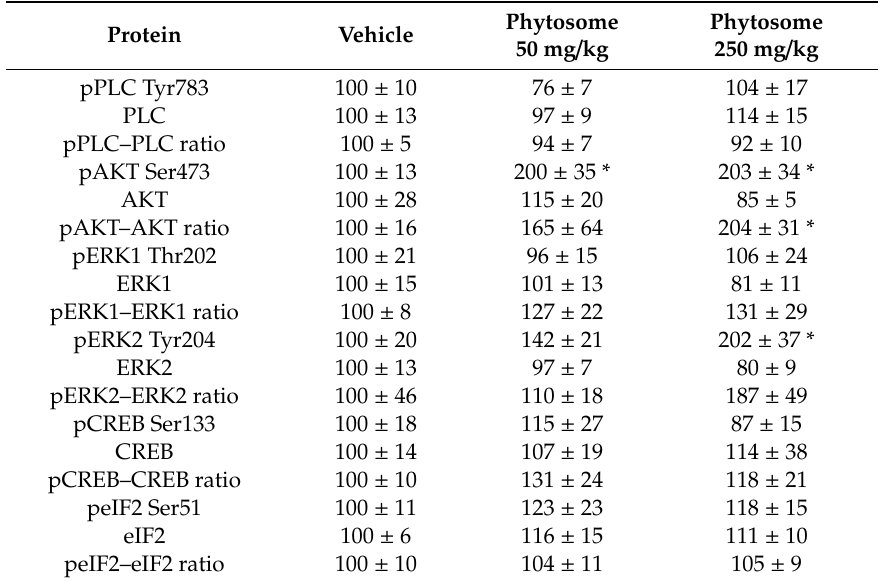
Table 3. Analyses of PLC, AKT, ERK1, ERK2, CREB, eIF2 (phosphorylated and total) protein levels in the PFC of rats treated with phytosome 50 mg / kg or 250 mg / kg. Data are expressed as percent change of vehicle treated rats and are expressed as mean ± SEM of 3–6 independent determinations. * p < 0.05 vs. vehicle; one-way ANOVA with Fisher’s